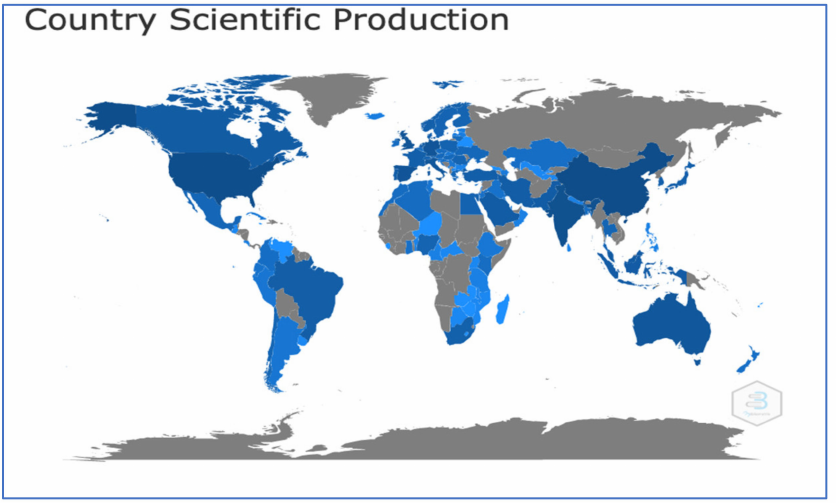
Figure 4. Country specific production of articles indexed in Scopus and Web of Science (keyword “renewable energy” 2019–2021). The blue illustrates the number of publications in selected countries— the darker the colour, the more publications in the analysed